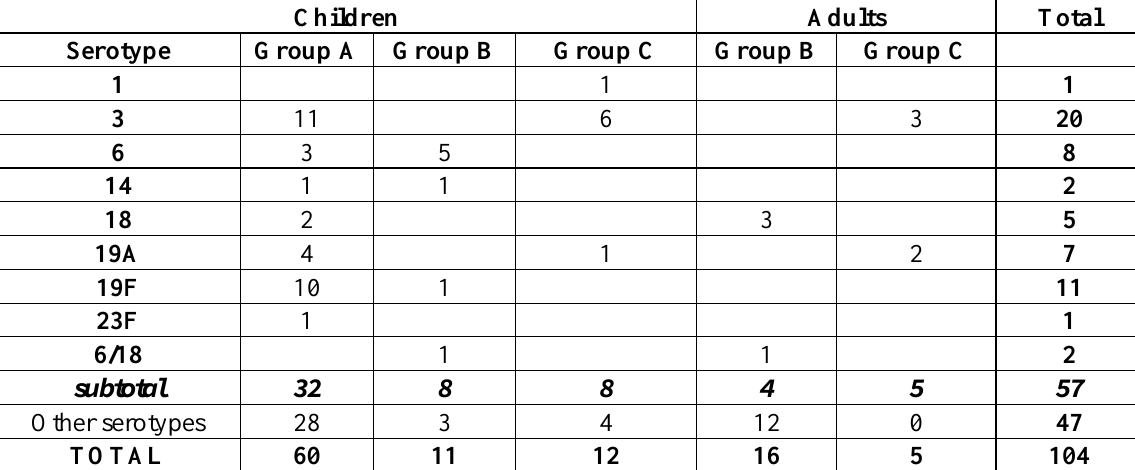
Table 3. Pneumococcal serotypes according to patient category and age